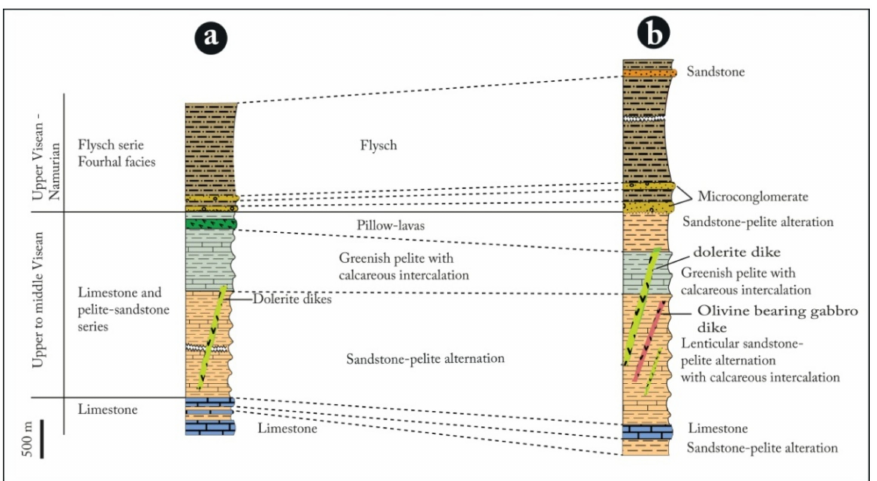
Figure 5. Correlation between synthetic lithostratigraphic logs of the southern ( a ) and northern ( b ) sectors of study